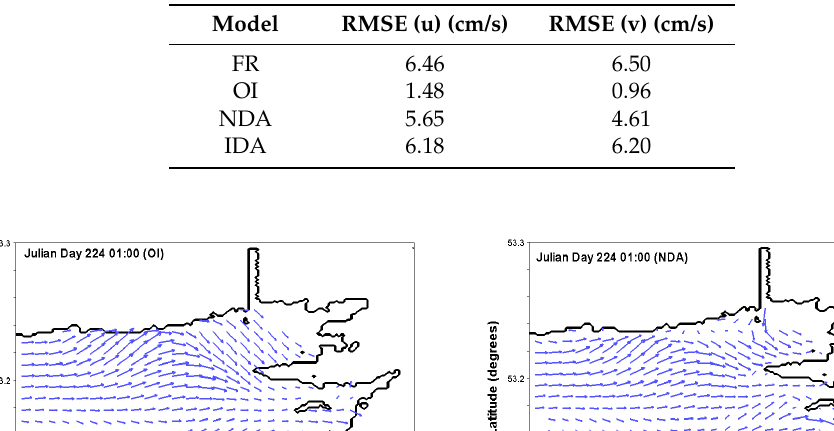
Table 1. RMSE between models and radar data (Julian Day 224 01:00).